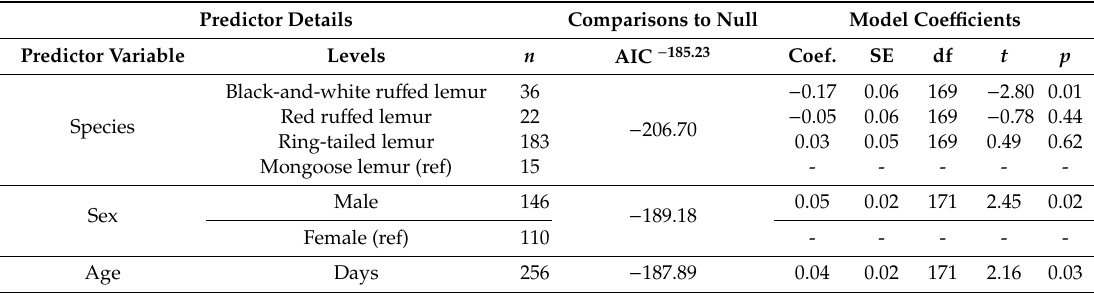
TableA5. Detailsofpredictorvariablesfoundtohaveaunivariablerelationshipwiththeepidemiological outcome, relative body mass. Random e ff ects were ‘enclosure’ nested in ‘zoo’. For each predictor varying intercepts, but common slopes, were found to be the best fit to the data. n = number of animals. AIC − 185.23 = AIC value of the null model (i.e., without predictor terms). Coef. = coe ffi cient. SE = standard error. df = degrees of